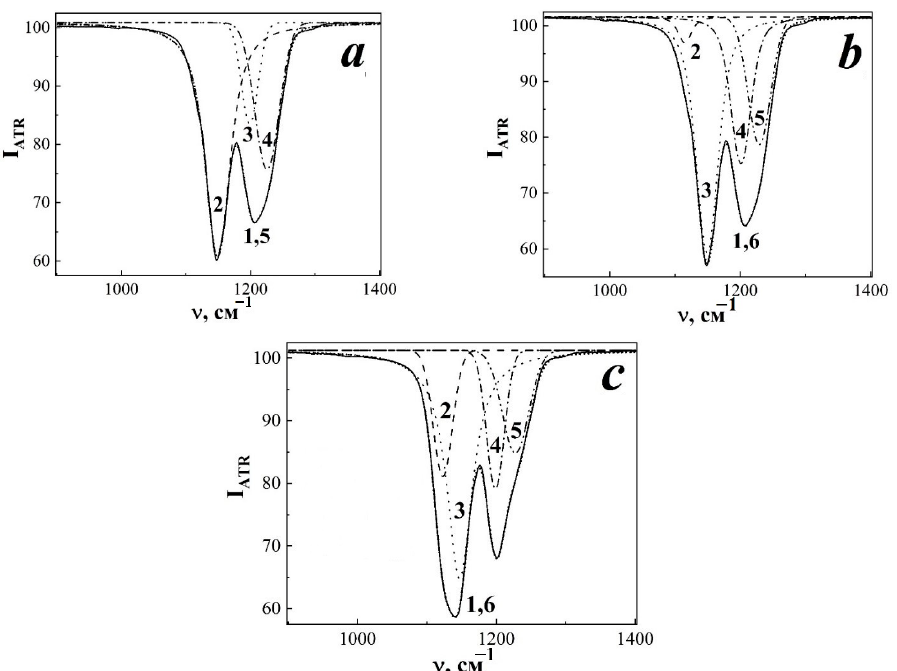
Figure 2. Approximation of the infrared spectra of the disturbed total internal reflection of the initial ( a ) and irradiated with accelerated xenon ions up to 10 8 and 10 11 cm − 2 ( b , c , respectively) thermora- diationally modified polytetrafluoroethylene. 1 ( a – c ) Experimental data; 2–4 ( a – c ), 5 ( b , c ) maxima of approximating random functions; 5 ( a ), 6 ( b , c ) result of approximation.